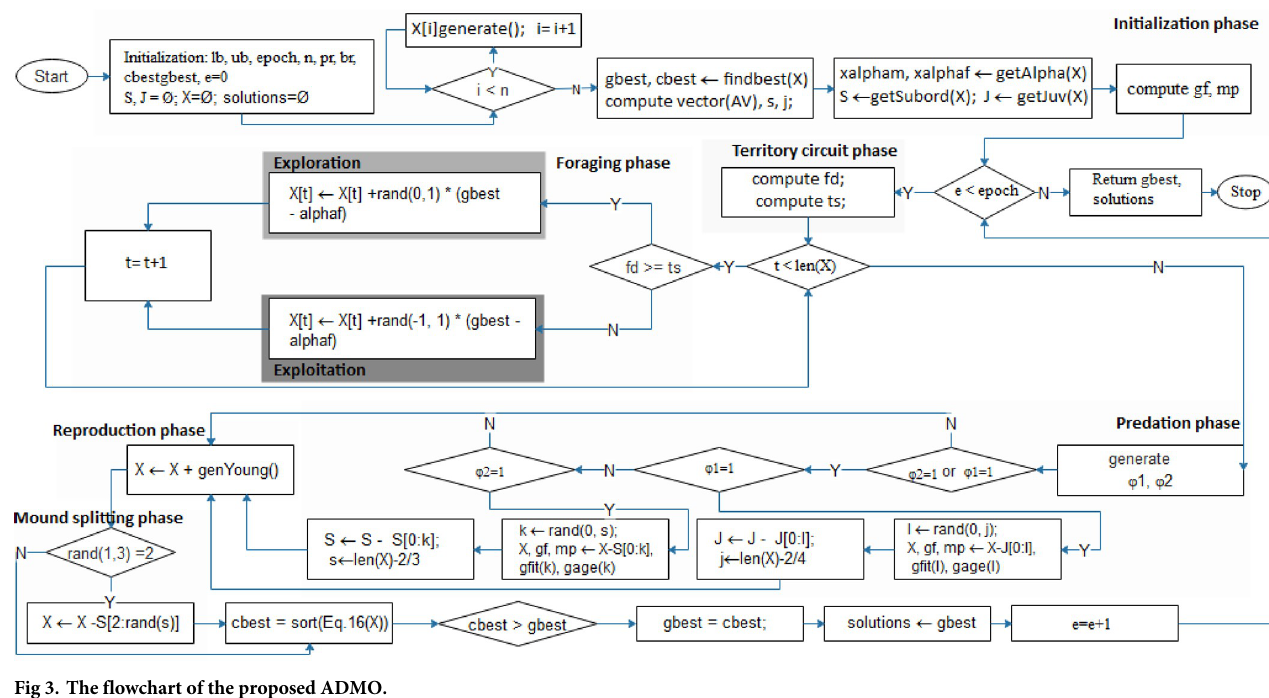
Fig 3. The flowchart of the proposed ADMO.